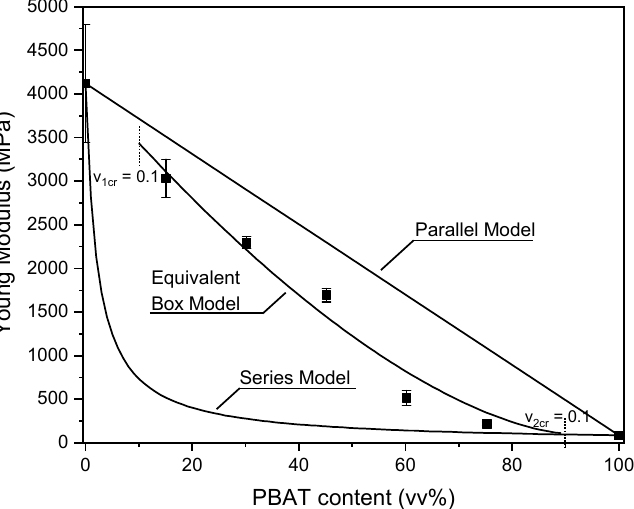
Figure 9. Experimental and theoretical values of the elastic modulus of the produced blends as a function of the PBAT content.